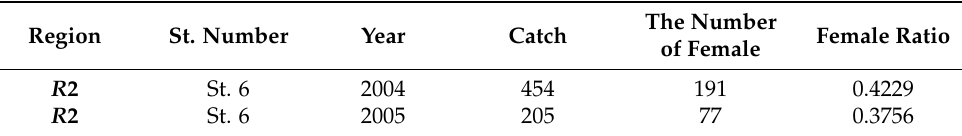
Table A2. The catch of chum salmon ( Oncorhynchus keta ) individuals and the number of females (Female ratio) in the R 2